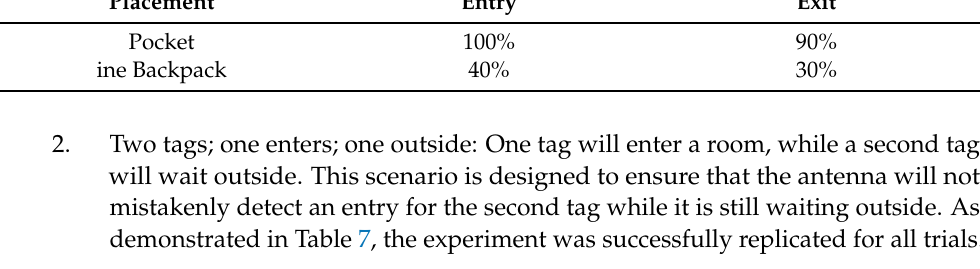
Table 6. Repeatability test with tag placed in pocket and in backpack. Placement Entry Exit Pocket 100% 90% ine Backpack 40% 30%